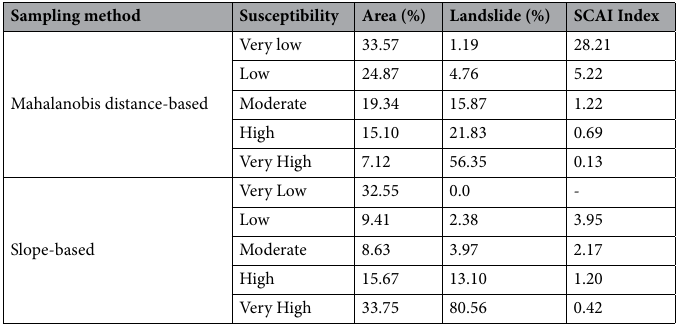
Table 3. SCAI values for each susceptibility zones of Mahalanobis distance-based landslide susceptibility mapping.